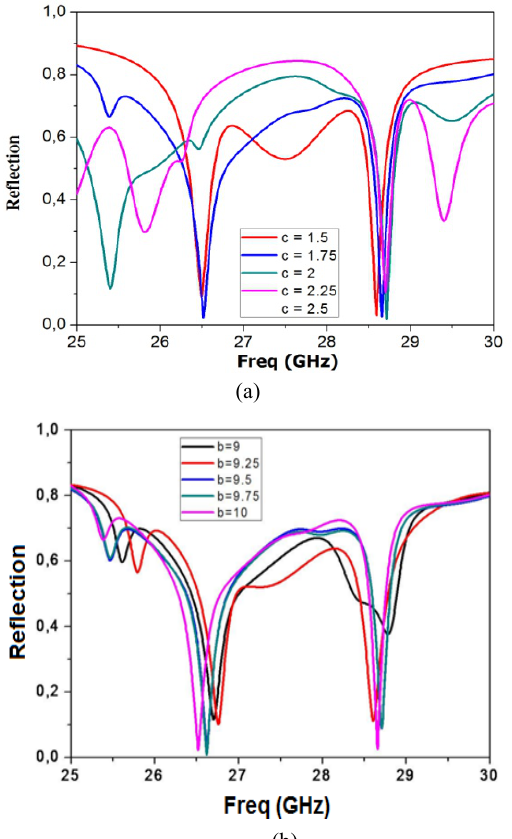
Figure 4: The dependence of absorption frequency on the